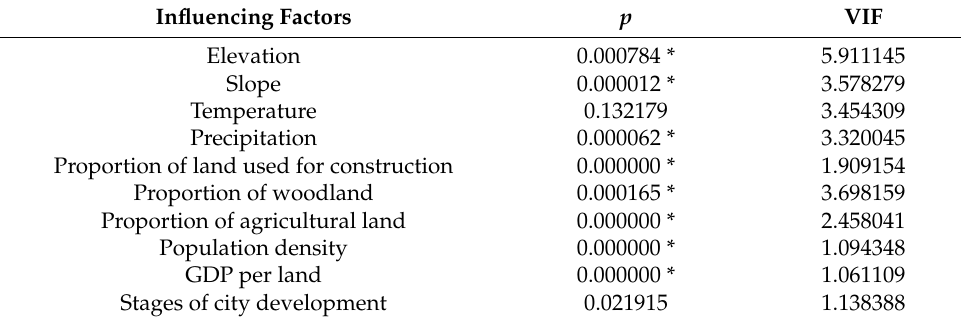
Table 6. Significance of influencing factors according to VIF.